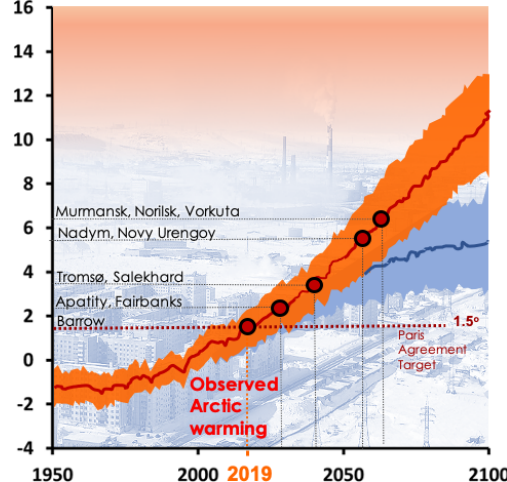
Figure 4. The northern urban heat islands are forerunners of the global warming. Winter season future temperatures for the Arctic (60–90 ◦ N) averaged over 36 CMIP5 global climate models and ex- pressed as departures from the means for the 1981–2005 period. The red line is the ensemble mean for RCP8.5, and the blue line is for RCP4.5. Shaded areas denote ± 1 standard deviation from the ensemble mean (Overland et al., 2014 and Fig. 2.15 of AMAP, 2017). The observed surface UHIs are shown as red dots collocated with the expected future Arctic temperature anomalies; e.g. the observed wintertime urban temperature anomaly in Nadym corre- sponds to the regional warming as expected to be reached by 2060. Observe that the present Arctic climate is already 1.5 ◦ C warmer than the historical normals